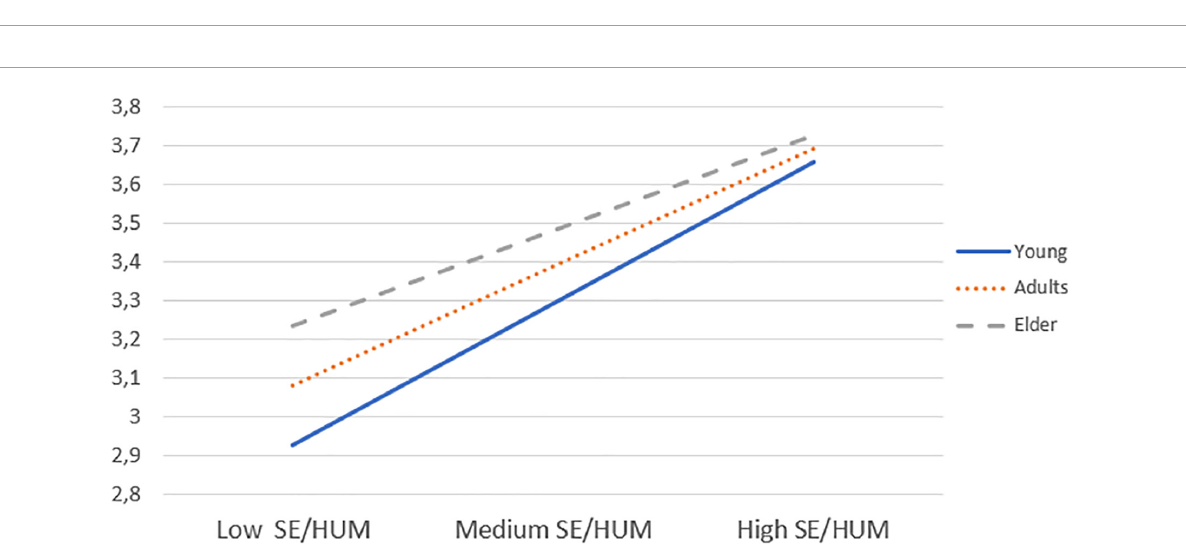
FIGURE1 Path diagram of the factorial structure of self-efficacy in managing positive emotions.